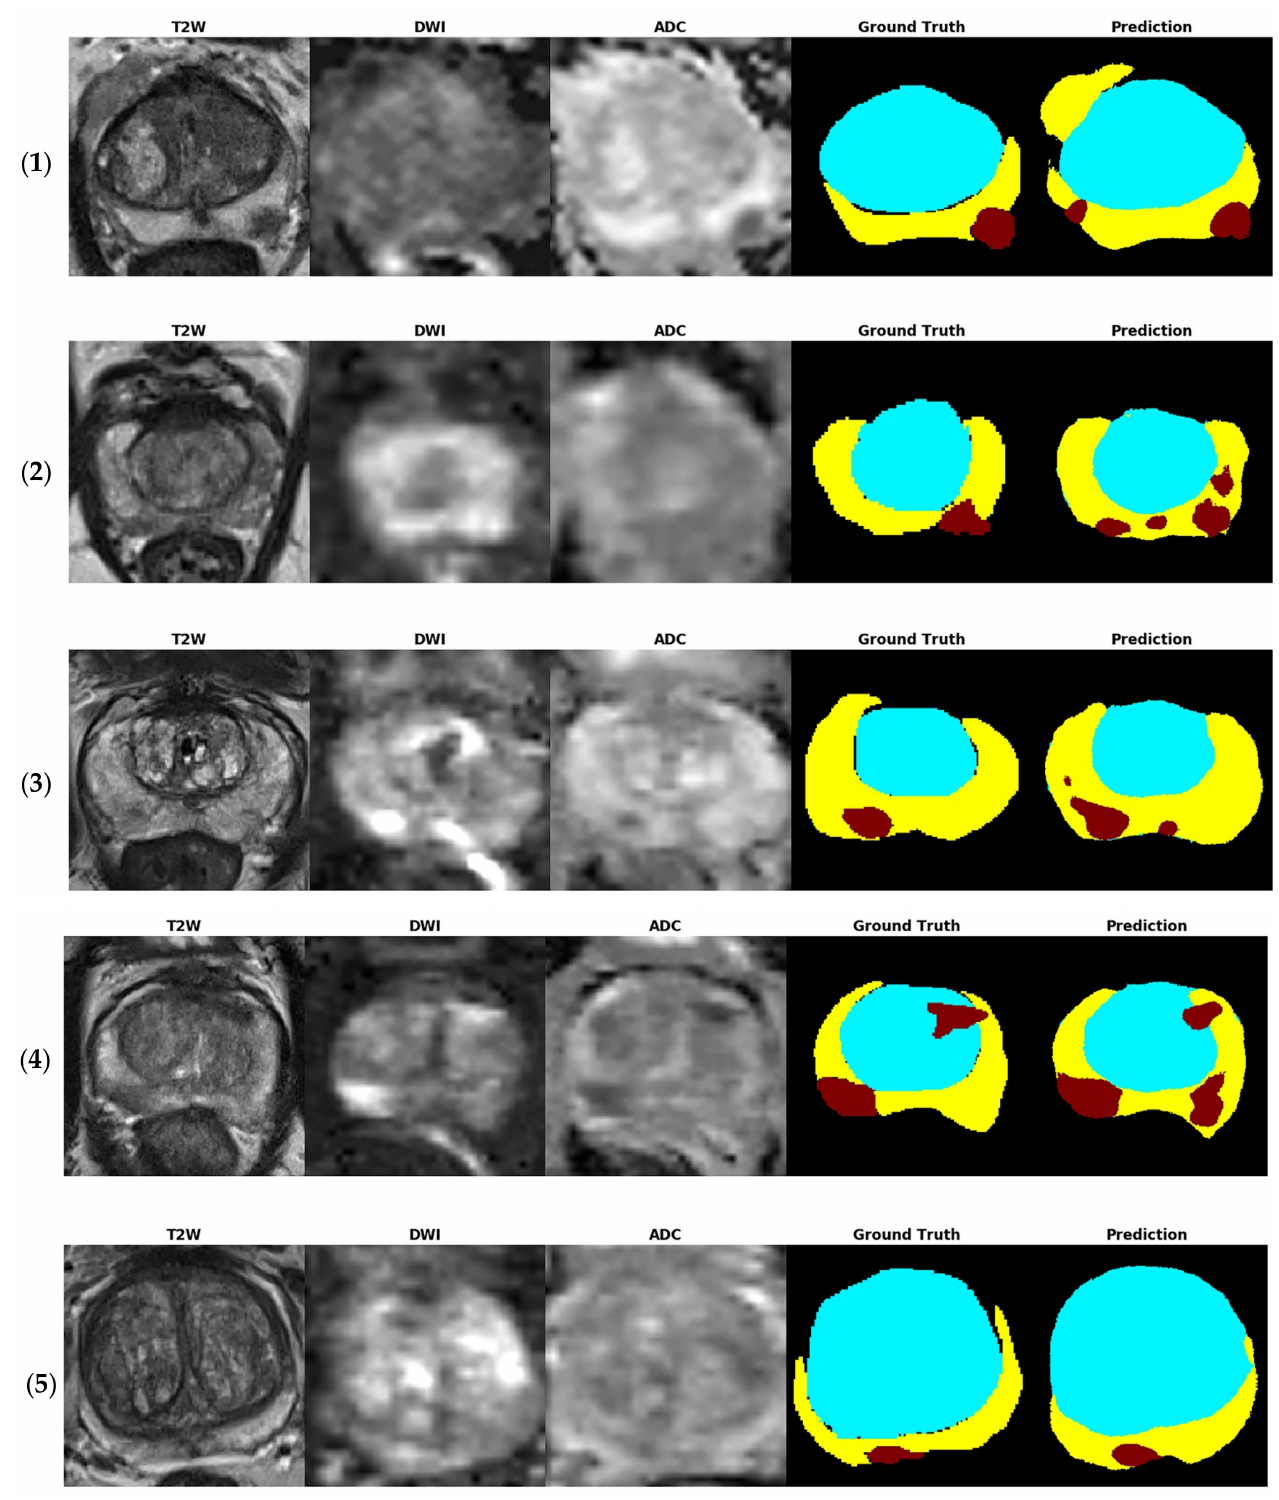
Figure 4. Test images of five patients ( 1 – 5 ) in the T2W image + DWI + ADC image model. The tumor location was provided from dataset. The ground truth images of segmentation and the corresponding prediction results are illustrated (blue region: TZ, yellow region: PZ, and red region: